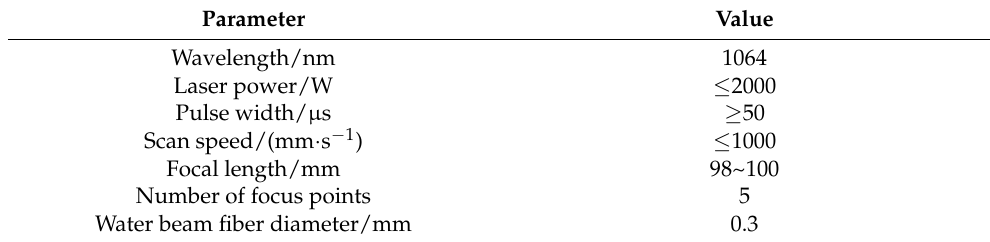
Table 3. Main technical parameters of the waterjet-guided laser processing